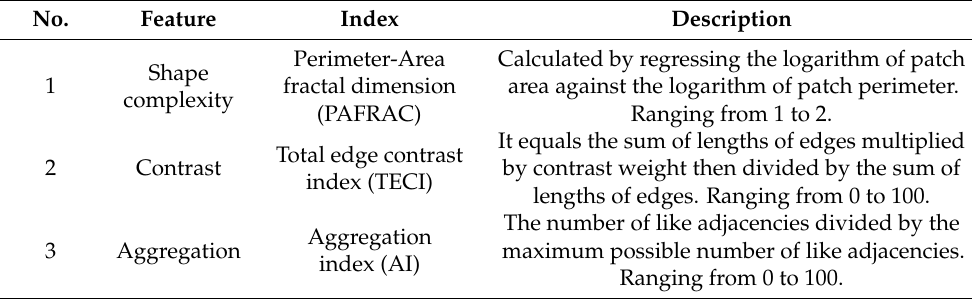
Table 10. Landscape indices and the corresponding features to reflect.